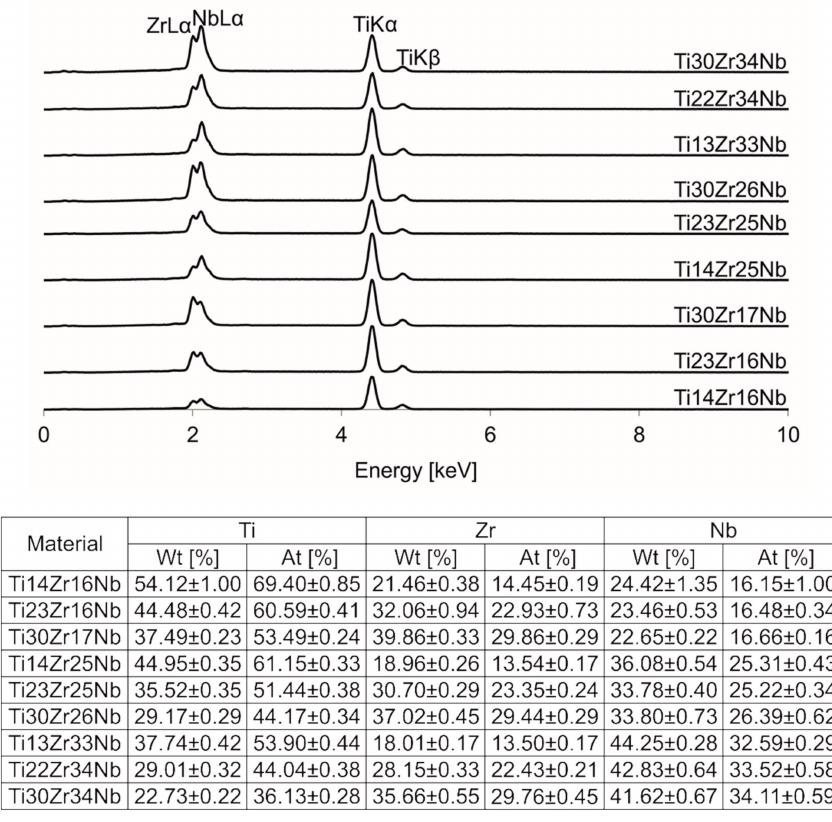
Figure 5. Energy-dispersive spectroscopy (EDS) spectra of Ti-Zr-Nb